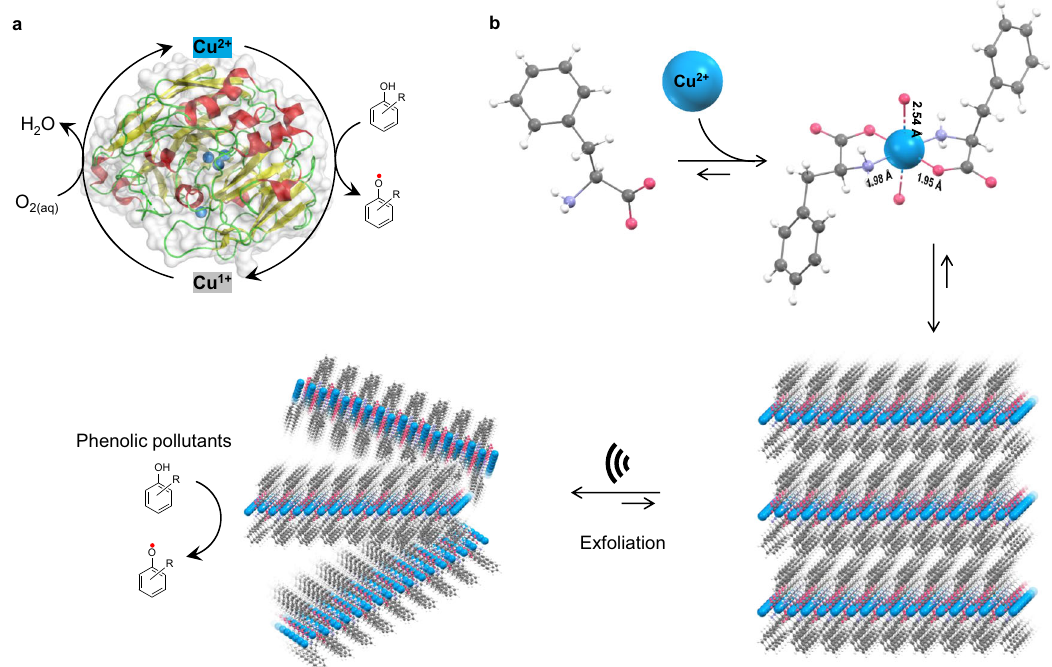
Fig. 1 Bioinspired design of a laccase-mimicking F-Cu 2D layered bionanozyme. a Structure of natural Laccase (PDB entry 1V10), comprised of a redox (Cu 2 + /Cu 1 + ) multicopper-coordinated catalytic site involved in the catalytic oxidation of toxic phenolic compounds into phenoxy radicals via reduction of oxygen to water. b Chemical structure and anticipated schematic illustration of F-Cu nanozyme formation. F spontaneously coordinates with Cu 2 + via carboxylate amine chelating modes into a hierarchical 2D van der Waals layered F-Cu structure. Further mechanical (ultrasonication) exfoliation to F-Cu monolayers facilitates laccase-mimicking oxidation of environmentally toxic